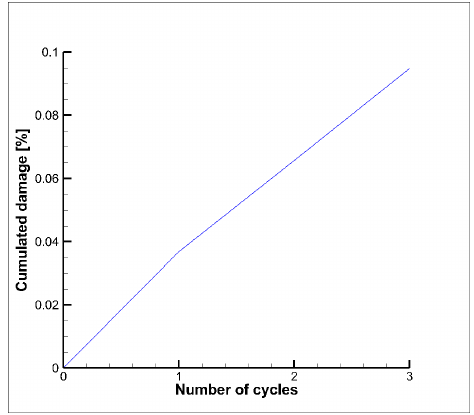
Figure 16. Cumulated damage vs. number of cycles—SWT method.